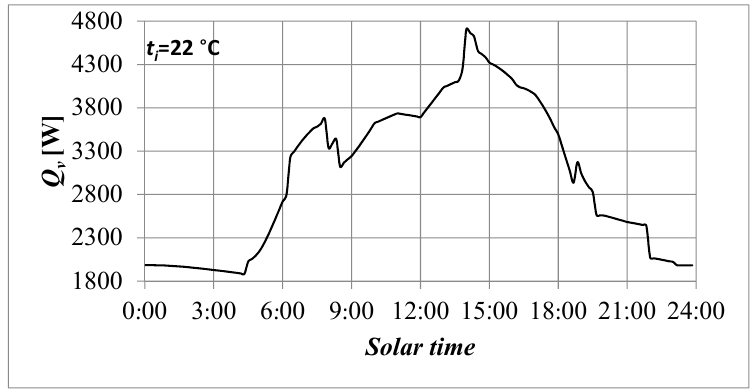
Figure 1. Required cooling load, Qv.